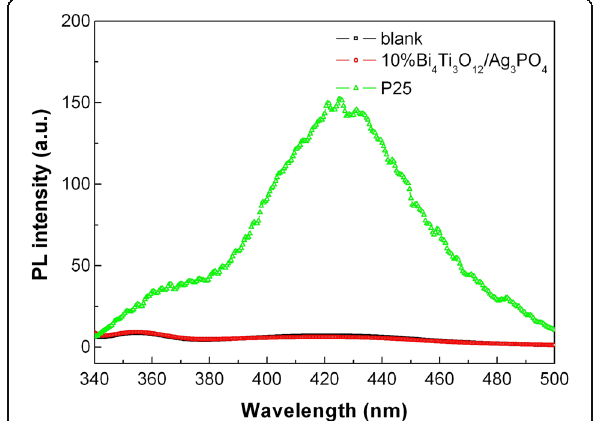
Fig. 11 PL spectra of the TPA solution reacted for 30 min over 10% Bi